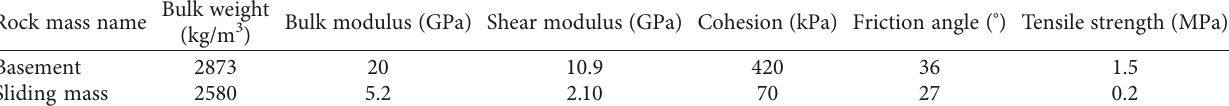
Table 2: Parameters of rock mechanics.